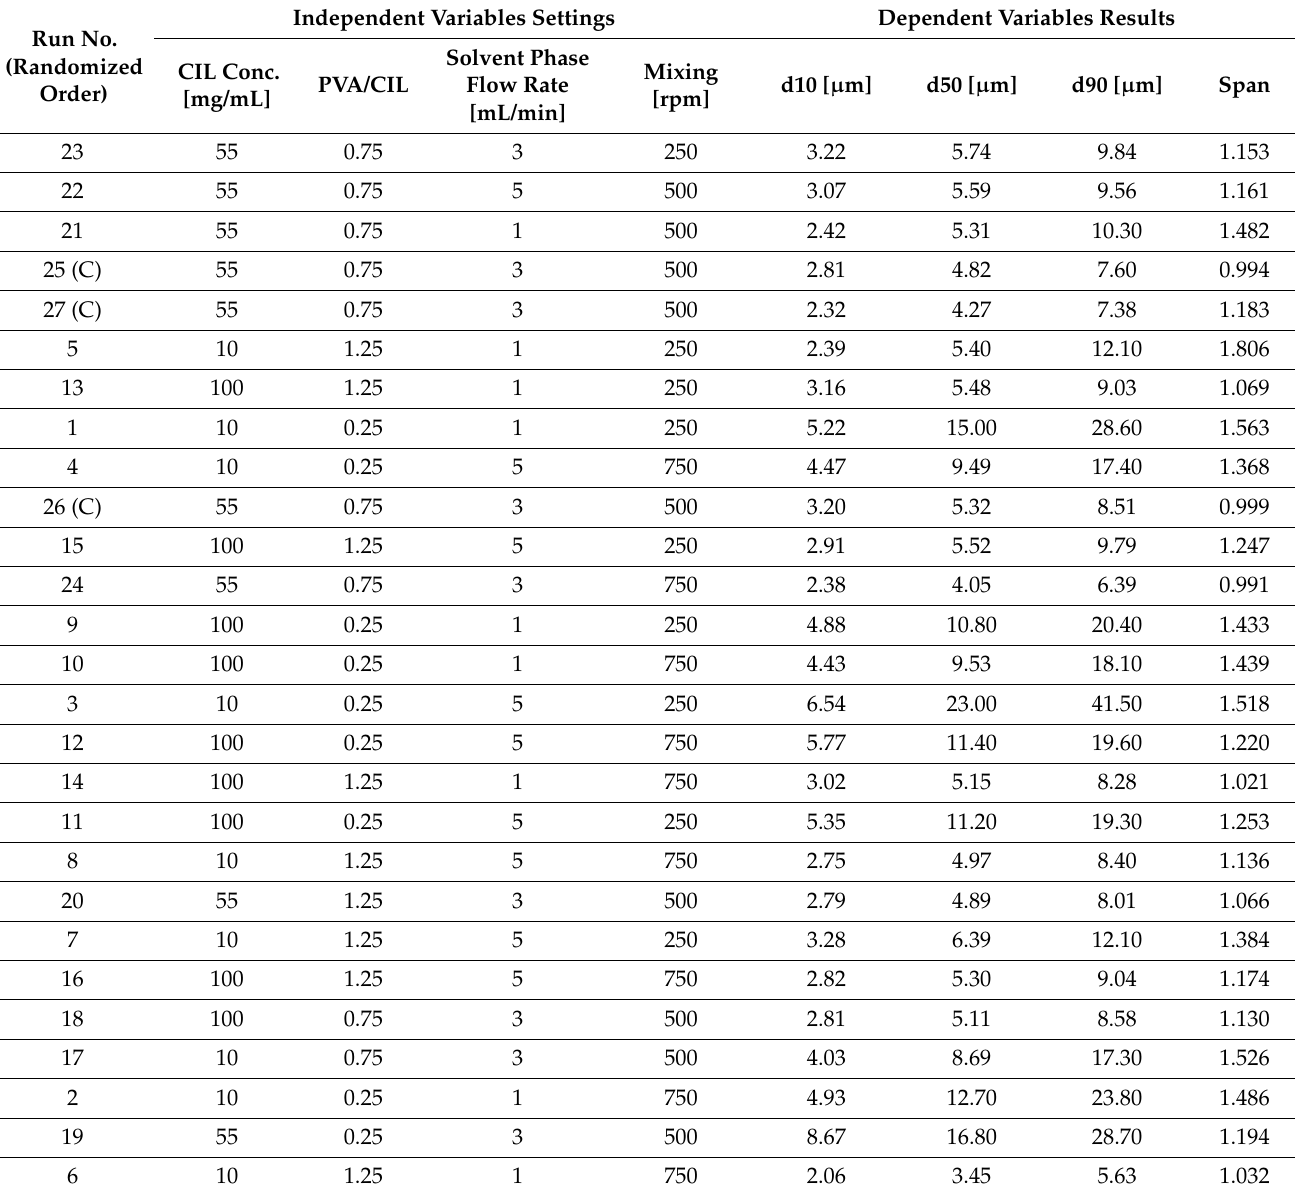
Table 1. Independent variable settings and results of central composite design experiments used in liquid antisolvent precipitation optimization and characterization. ‘(C)’ marks central points of the